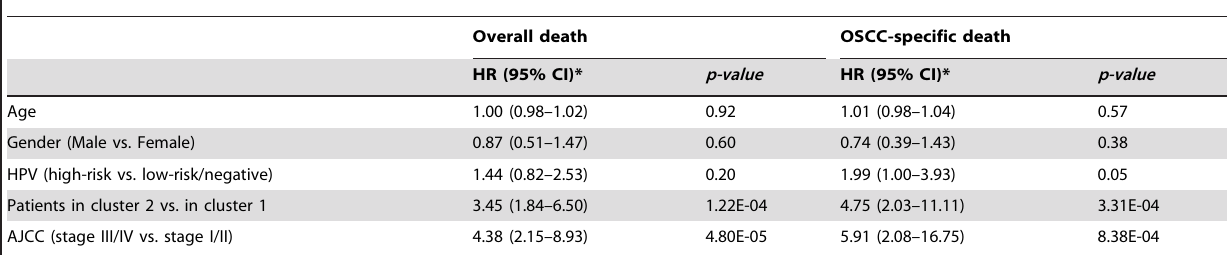
Table 2. Multivariate analysis for overall and OSCC–specific survival.